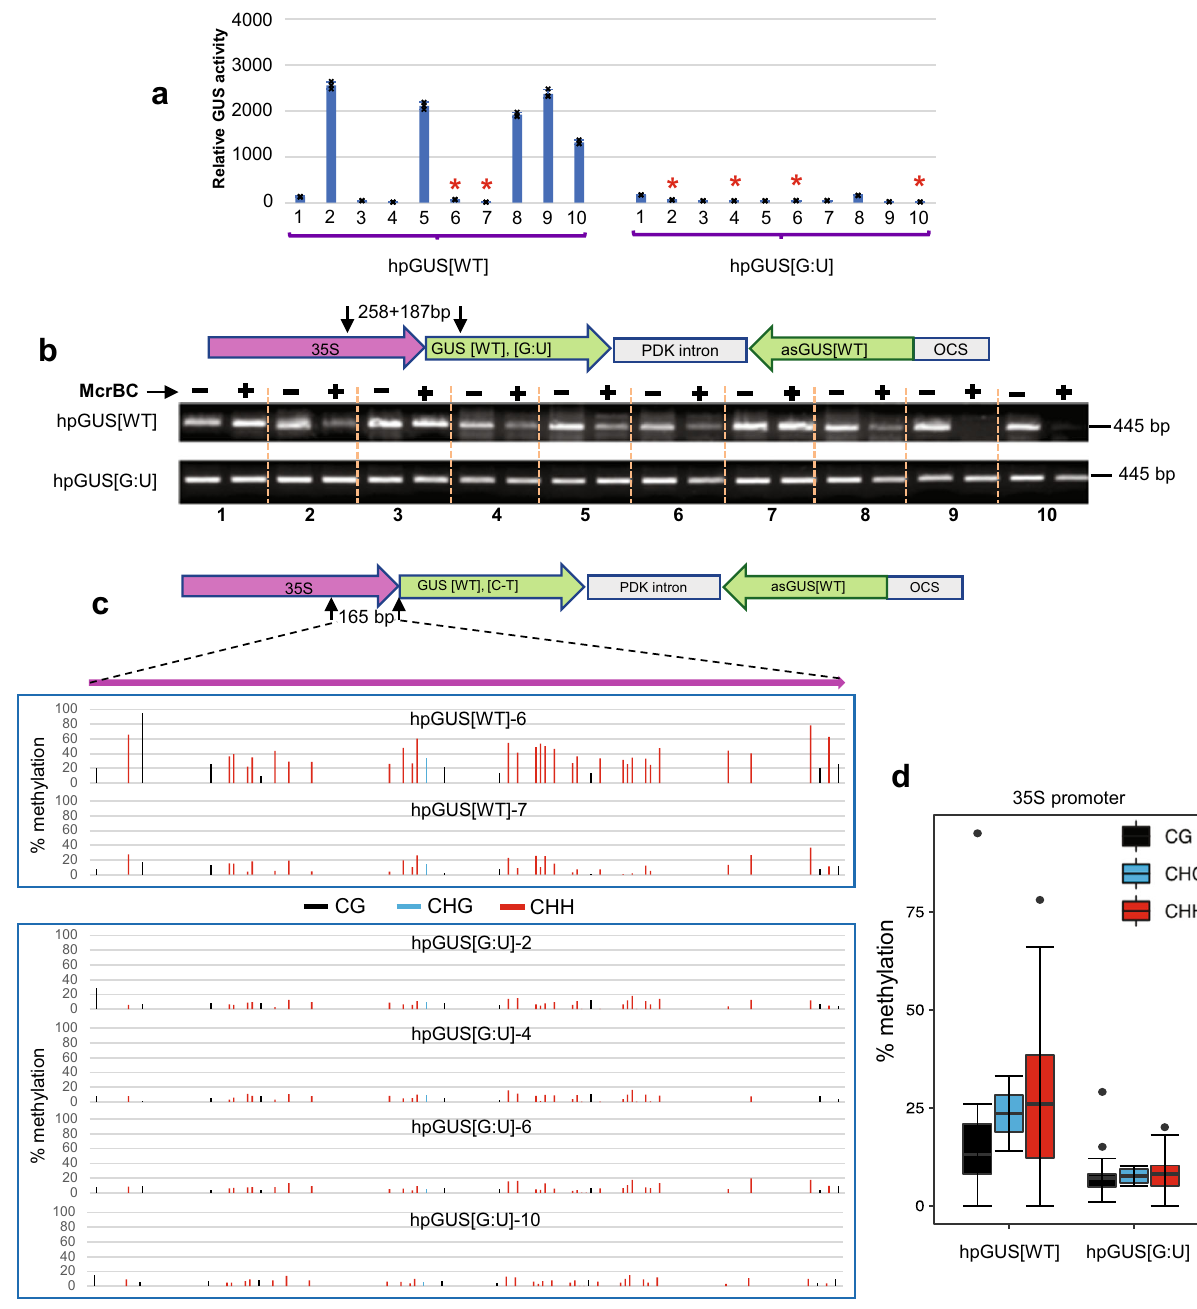
Fig. 4 G:U modi fi ed hpRNA transgenes show reduced DNA methylation at the promoter region. a GUS expression patterns of the independent transgenic lines were analyzed by McrBC-digestion PCR. Three technical replicates were measured for each line, and data are presented as mean values ± s.d. with the three data points shown as black cross. The red asterisks indicate the lines analyzed by bisul fi te sequencing in ( c ). b McrBC-digestion PCR analysis of the 35S promoter-sense junction regions in the hpGUS transgenes as de fi ned by the two arrows (the locations of forward and reverse PCR primers). McrBC is an endonuclease that only cleaves DNA containing methylated cytosine bases. Comparing PCR ampli fi cation of McrBC-treated with untreated DNA, therefore, provides an estimation of DNA methylation levels. DNA samples were either untreated ( − ) or treated ( + ) with McrBC before PCR ampli fi cation. c Bisul fi te sequencing of the 35S promoter regions (the top strand only) as indicated by the two arrows (the locations of the nested forward and reverse bisul fi te PCR primers). d Box plot (R version 3.6.0) showing the average CG, CHG, and CHH methylation levels for the 2 hpGUS[WT] and 4 hpGUS[G:U] lines in ( c ). The central horizontal line indicates the median value, the lower and upper borders of the box represent the fi rst and third quartiles, and the outliers are represented by dots. Bisul fi te treatment of genomic DNA converts unmethylated cytosine bases to uracil (U) (shown as thymine in PCR product) but methylated cytosines are not affected. PCR ampli fi cation of bisul fi te-treated DNA followed by sequencing, therefore, detects methylated cytosines at single-nucleotide resolution. PCR primers were designed to speci fi cally amplify only the 35S promoter sequences of the hpGUS transgenes but not the one driving HPT expression in the target GUS gene (Fig. 1a; 35S ′ ). Source data are provided as a Source Data fi